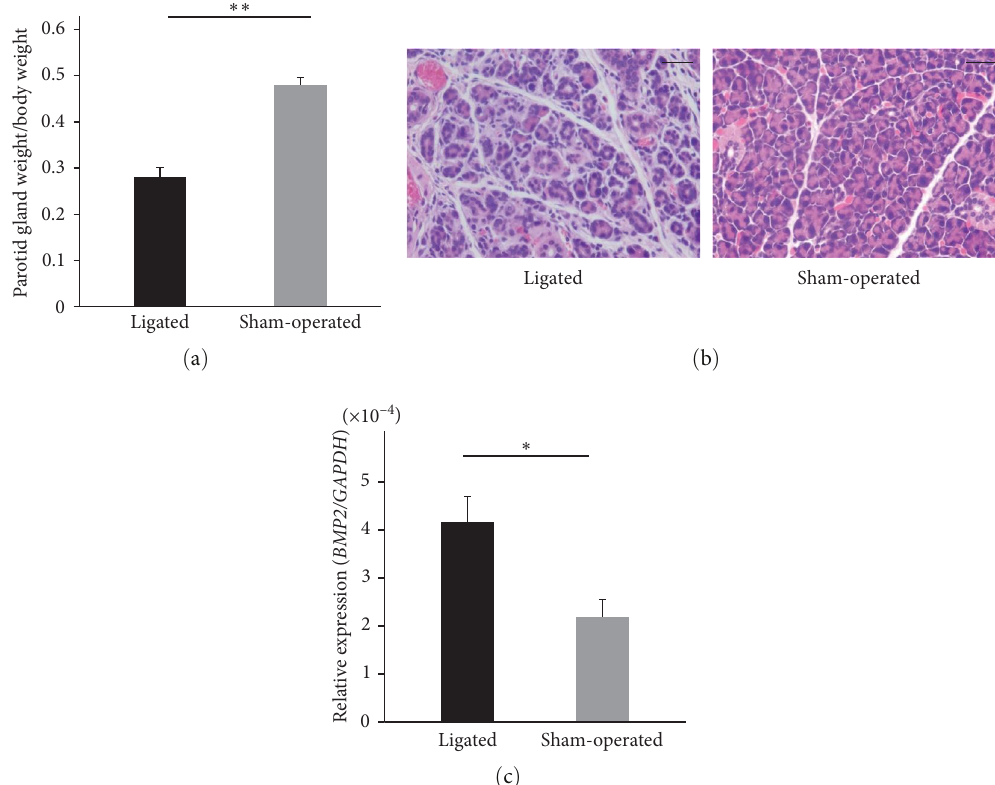
F IGURE 1: Changes in the parotid gland and expression of BMP2 after 7 days of unilateral parotid duct ligation in mice. (a) Weight of duct- ligated and sham-operated parotid glands. The duct-ligated parotid gland showed a signi fi cant decrease in weight. ∗∗ Indicates signi fi cance at P < 0 : 01. Data were shown as mean Æ SD ( n = 5). (b) Hematoxylin and eosin (H & E) staining of parotid glands in the ligated and sham- operated glands. Scale bar = 30 µ m. (c) Changes in BMP2 mRNA expression in duct-ligated and sham-operated parotid glands. BMP2 mRNA expression increased signi fi cantly in the duct-ligated parotid gland. ∗ Indicates signi fi cance at P < 0 : 05. Data were shown as mean Æ SD ( n =